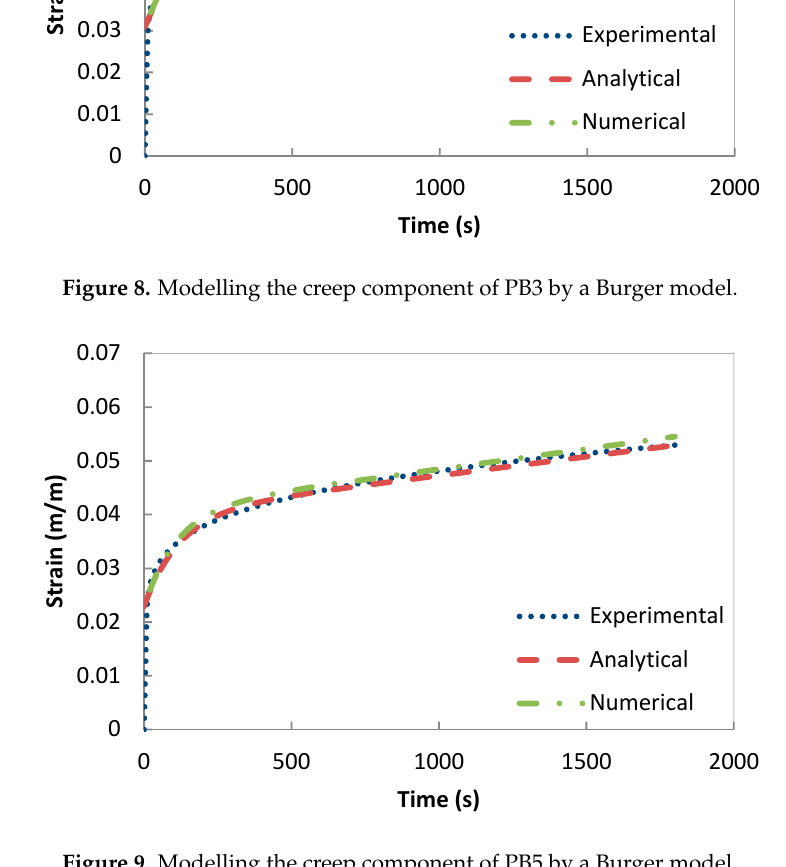
Figure 9. Modelling the creep component of PB5 by a Burger model.